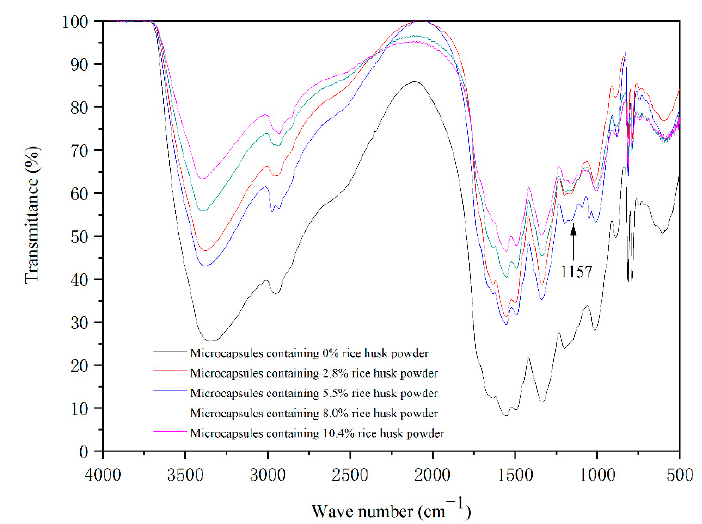
Figure 5. Infrared spectrum of microcapsules in the single-factor test.